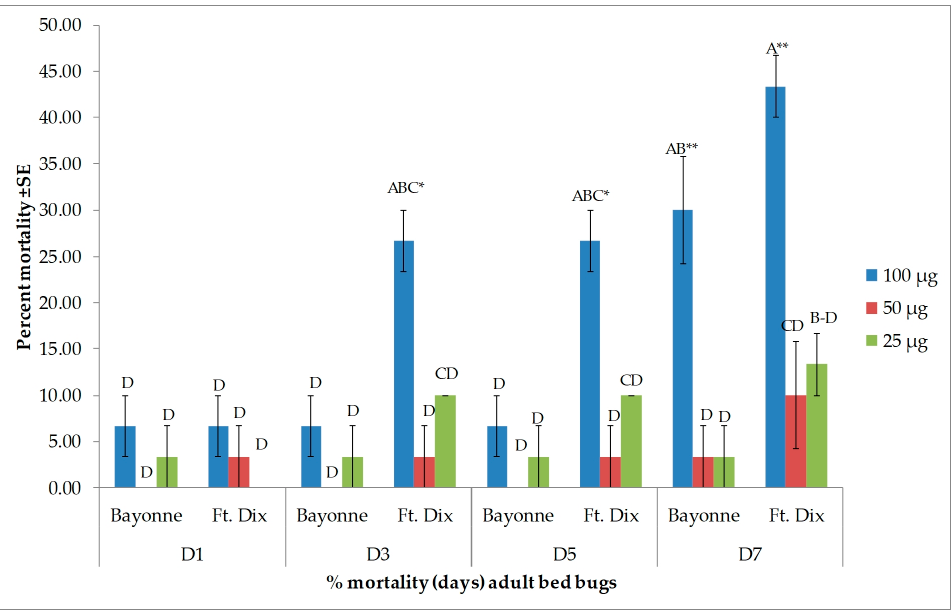
Figure 5. Mean (±SE) mortality produced by topical application of α -humulene on two strains of bed bug. Levels not connected by the same letter are significantly different. There were three replications per treatment with 10 bed bugs per replication (Three-Factor ANOVA, p < 0.05, mean separated by Tukey’s HSD Test; JMP® 10.0). Deltamethrin (2.4 ng, positive control) had killed 36.6% ± 3.33% (Bayonne) and 100% (Ft. Dix) at 24 h post treatment. The mortality rate in the Bayonne strain increased to 43.3% ± 8.82% from days 3 to 7. * The highest dose (100 µg) induced statistically higher mortality in the Ft. Dix strain (susceptible) when compared with the Bayonne strain (insecticide-resistant) F (2.48 = 5.04, p ≤ 0.0103) on days 3 and 5, ** while the difference became non-significant on day 7.